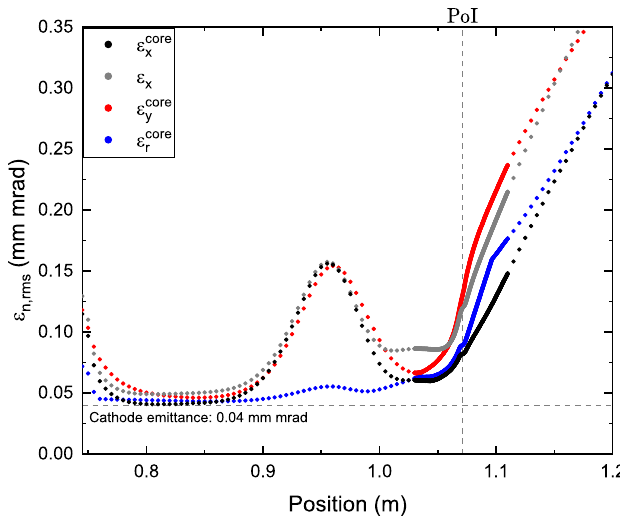
FIG. 10. Emittances of the bunch at the end of the beamline. The bunches pass through the PoI at z ¼ 1 . 07